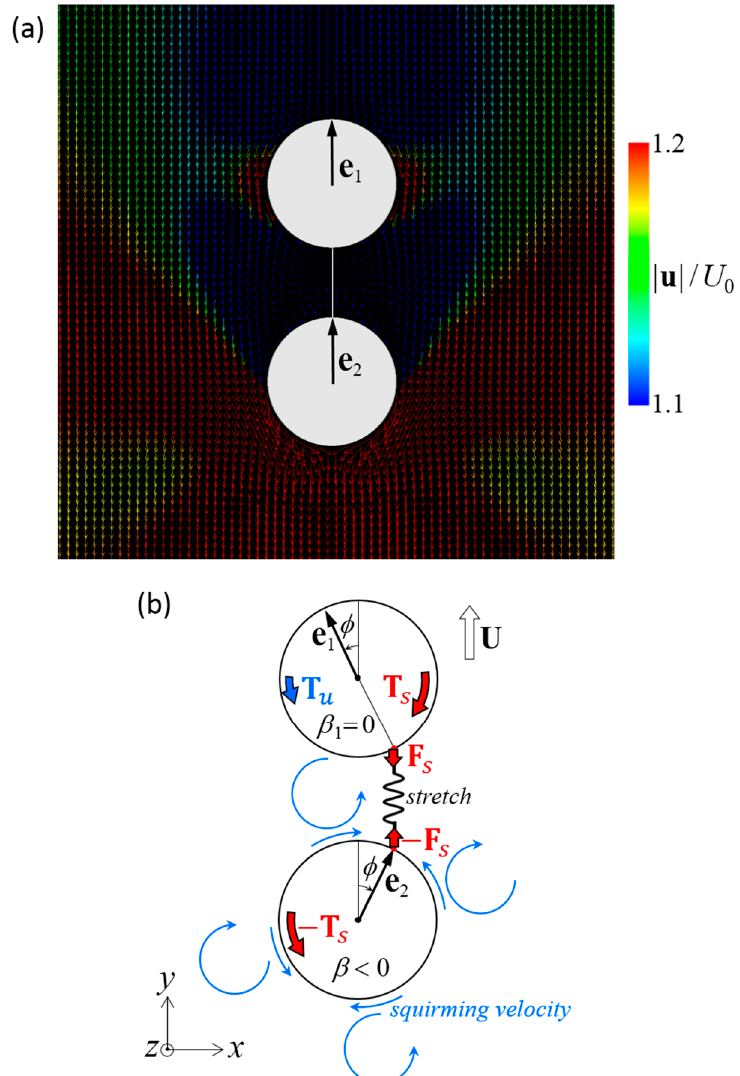
Figure 10. Mechanism of the stable swimming in a dumbbell squirmer connected fore and aft. ( a ) Velocity field around a stable dumbbell squirmer with β 1 = 0 and β 2 = − 3. ( b ) Schematics of the torque balance. Two squirmers tended to repel each other, and the spring was stretched. Spring force F s induces spring torque T s to the squirmer (red arrows). The spring torque stabilized the aligned configuration when it overwhelmed hydrodynamic torque T u , which was caused by the squirming